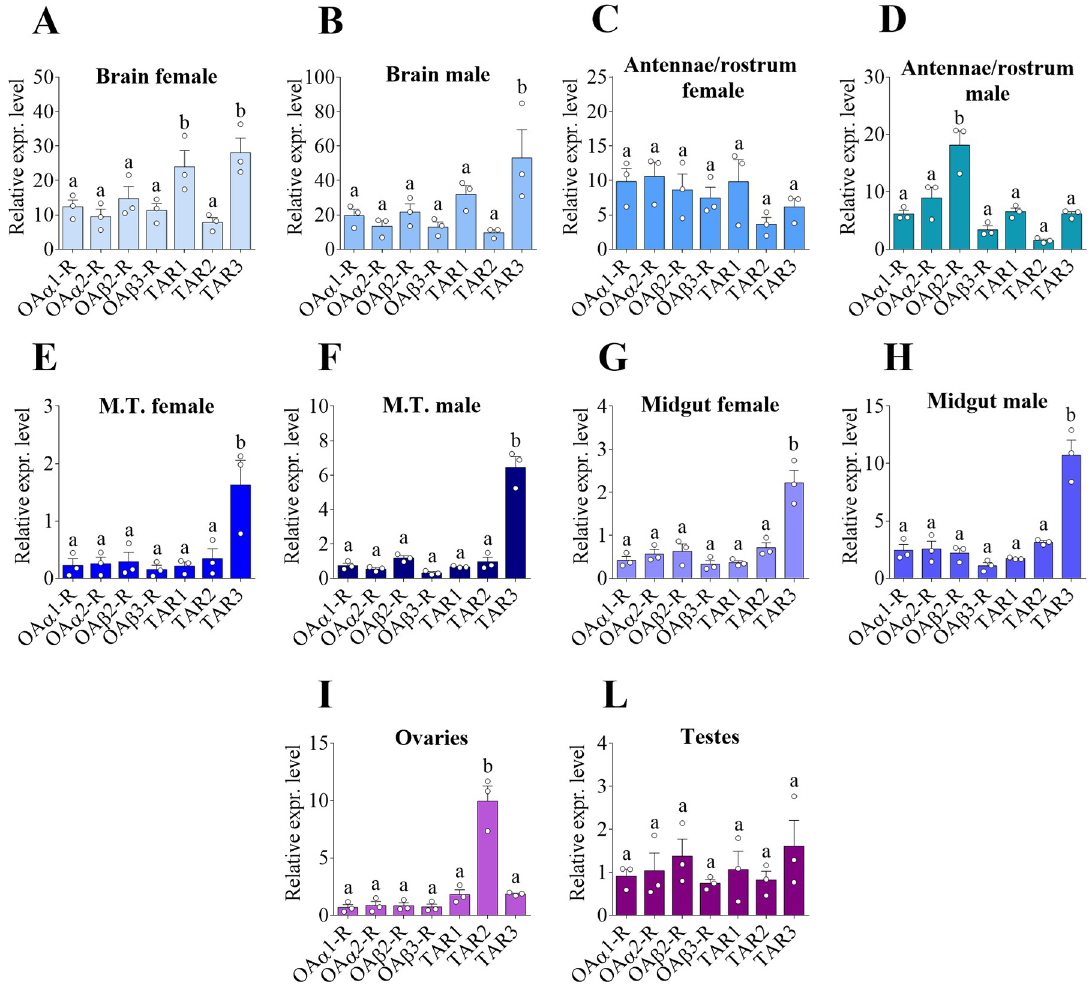
Fig 3. Expression pattern of OA and TA receptor transcripts among female and male adult A . aegypti tissues. Brain ( A, B ), antennae and rostrum ( C, D ), Malpighian tubules (MTs) ( E, F ), midgut ( G, H ) ovaries ( I ) and testes ( L ). Data represent means ± SEM of three biological replicates. One-way ANOVA followed by multiple comparisons Bonferroni post hoc test were performed. Statistical significance of p < 0.05 is indicated by different letters in panels A-L.